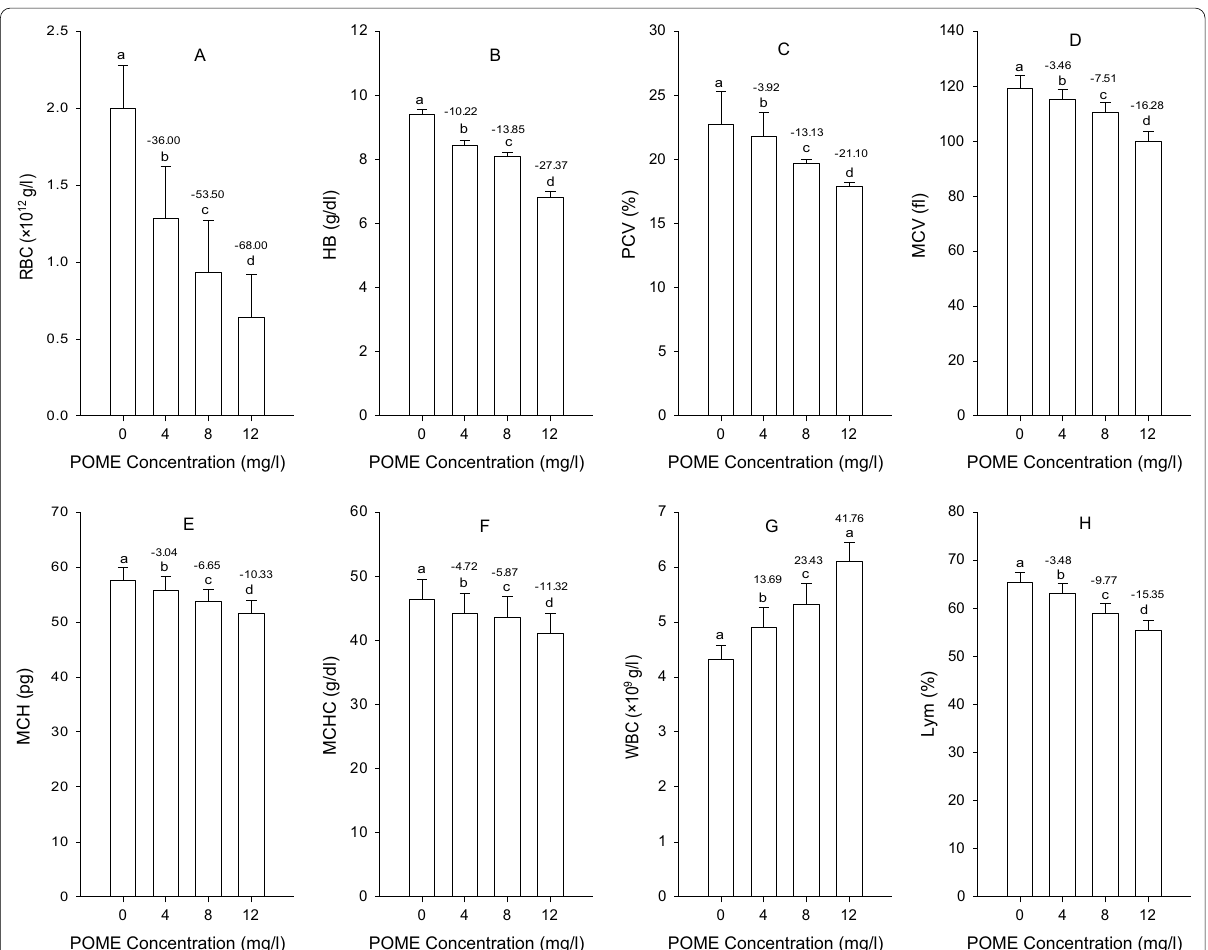
Fig. 1 Changes in haematological parameters of Heteroclarias exposed to different concentrations of POME for 28 days. a RBC (red blood cells), b HB (haemoglobin), c PCV (packed cell volume), d MCV (mean cell volume), e MCH (mean cell haemoglobin), f MCHC (mean cell haemoglobin concentration), g WBC (white blood cells) and h Lym